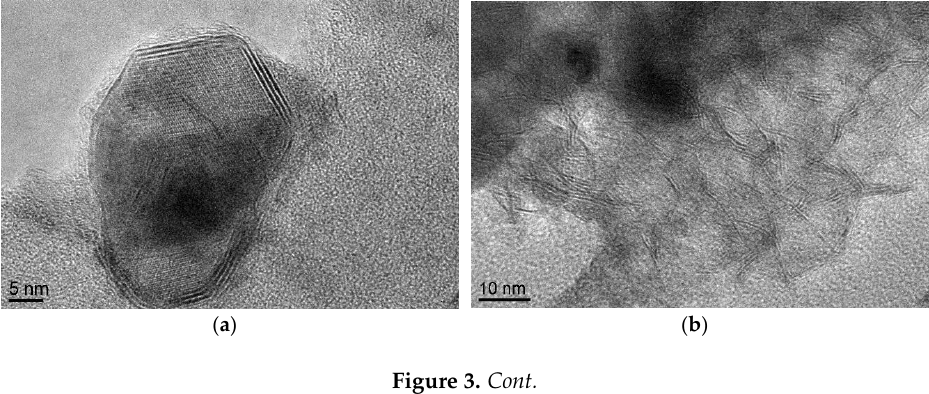
Figure 2. Photographic picture of porous aromatic framework infiltrated with different bimetallic